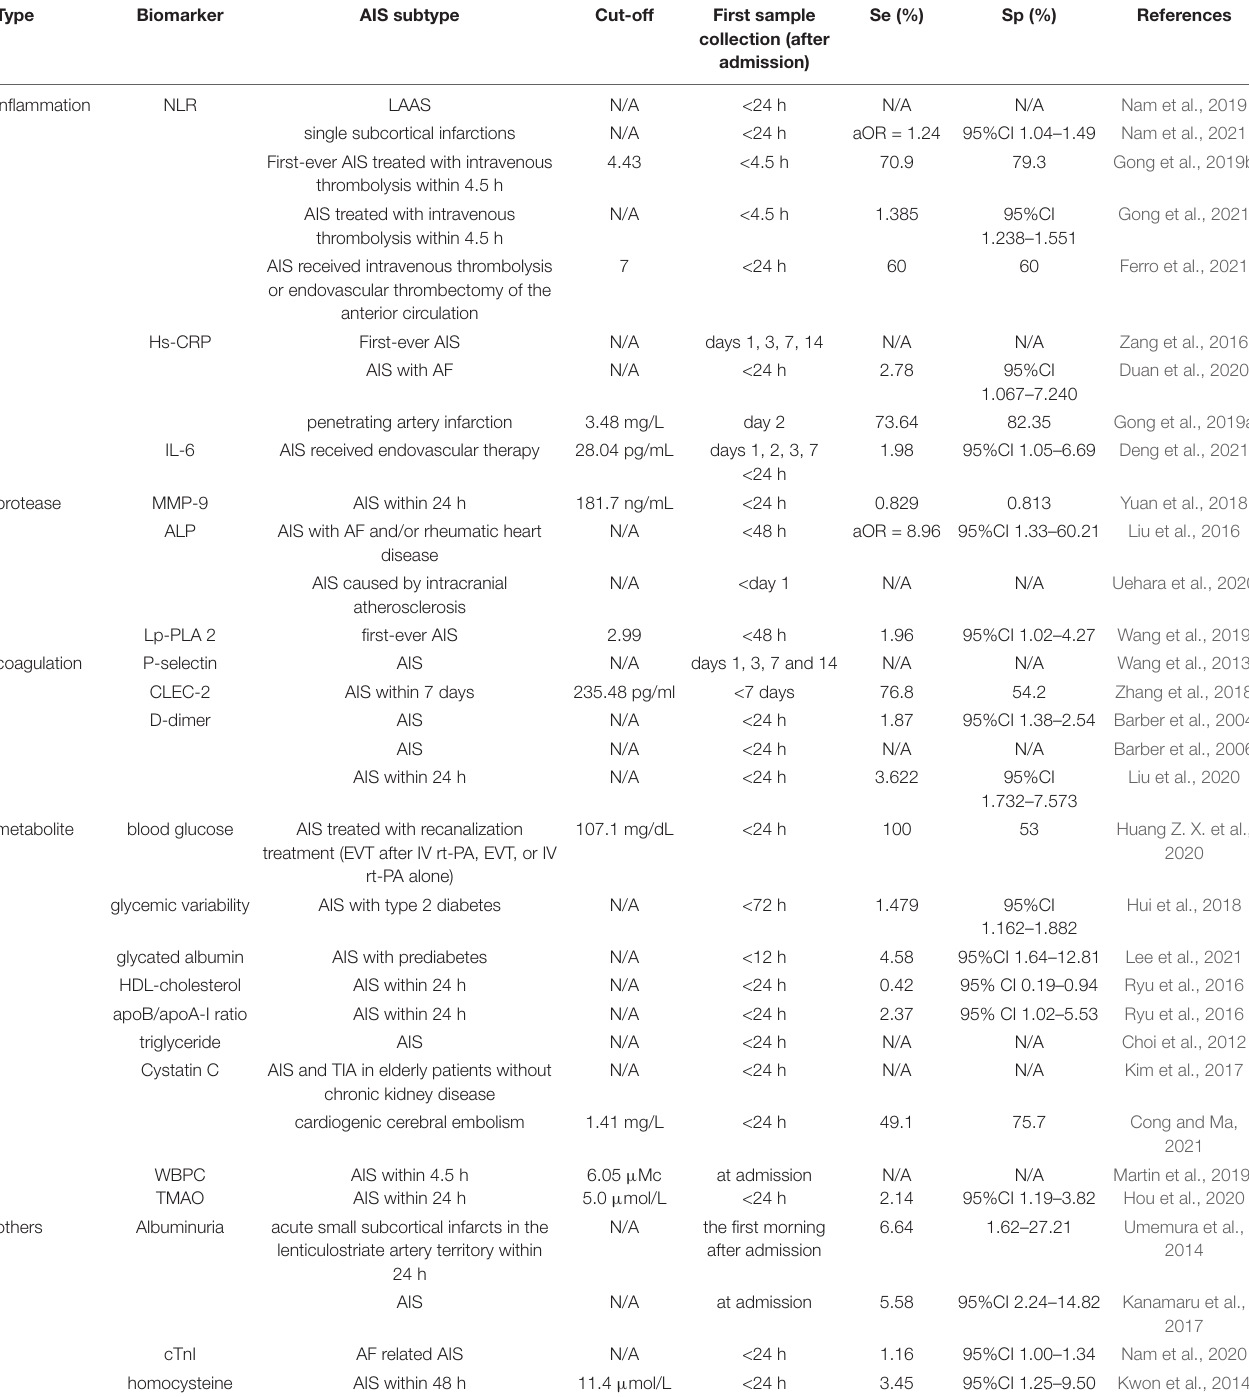
TABLE 1 | Published studies on the biomarkers of END following